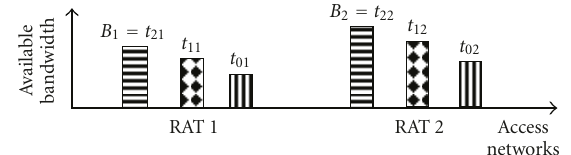
Figure 4: Accessible bandwidth for a two-class, two-RAT system.